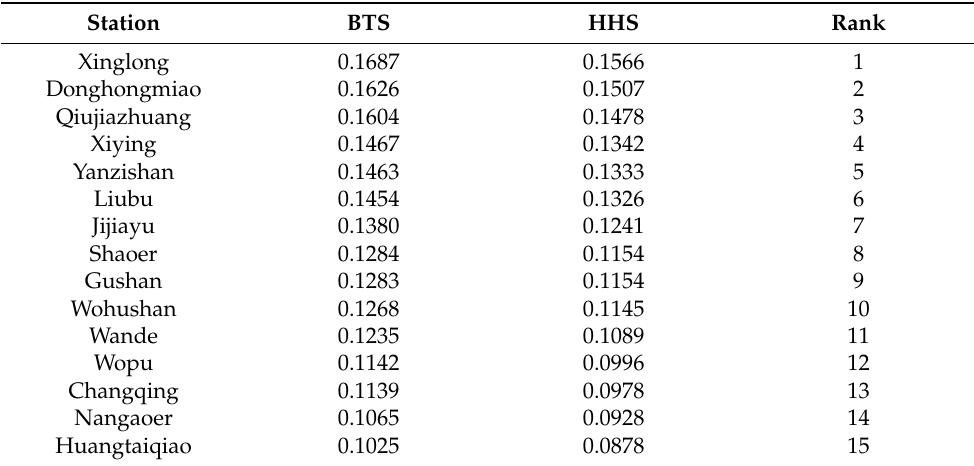
Table 3. Correlation coefficient of spring water level and precipitation.